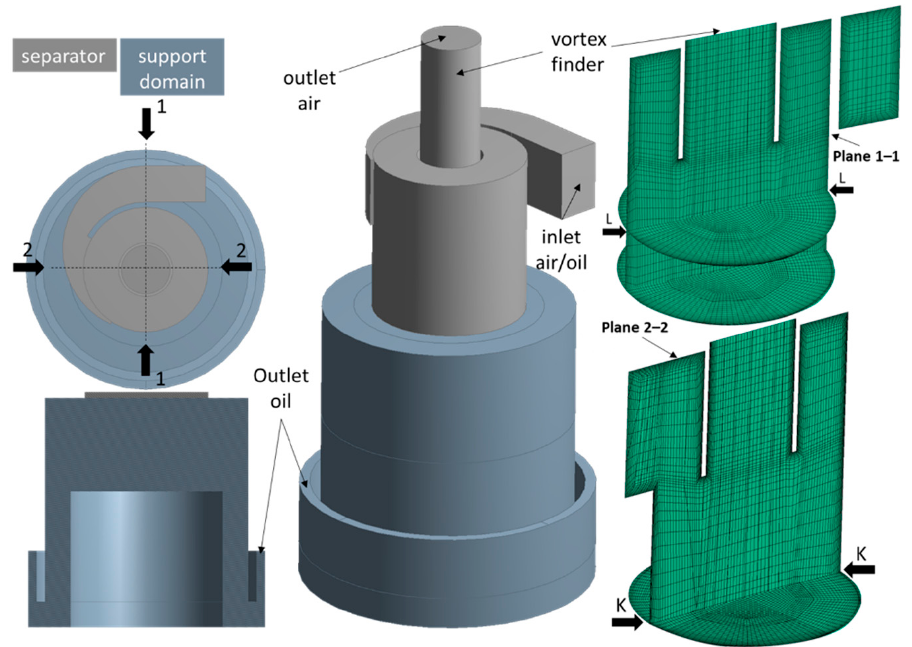
Figure 2. Calculation domain and numerical mesh.